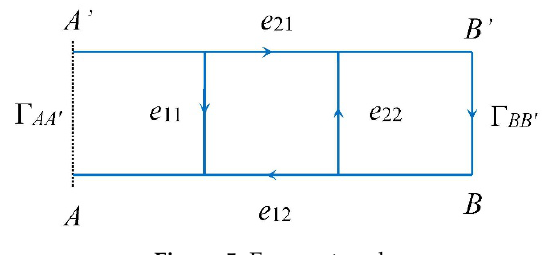
Figure 5. Error Figure 5. Error network.